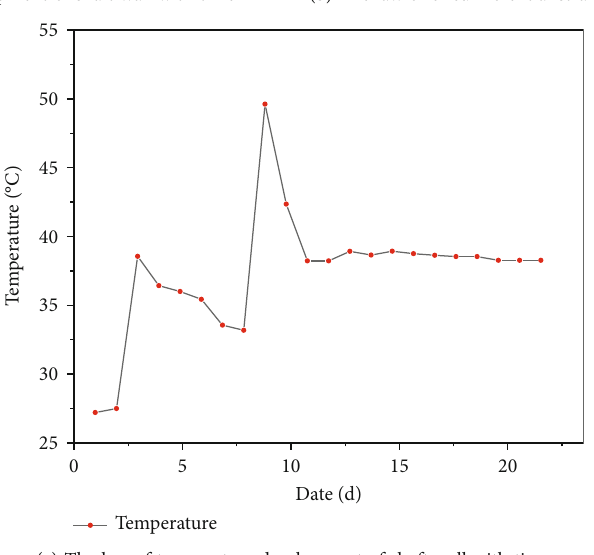
(c) The law of temperature development of shaft wall with time Figure 3: The law of strain and temperature development of shaft wall with